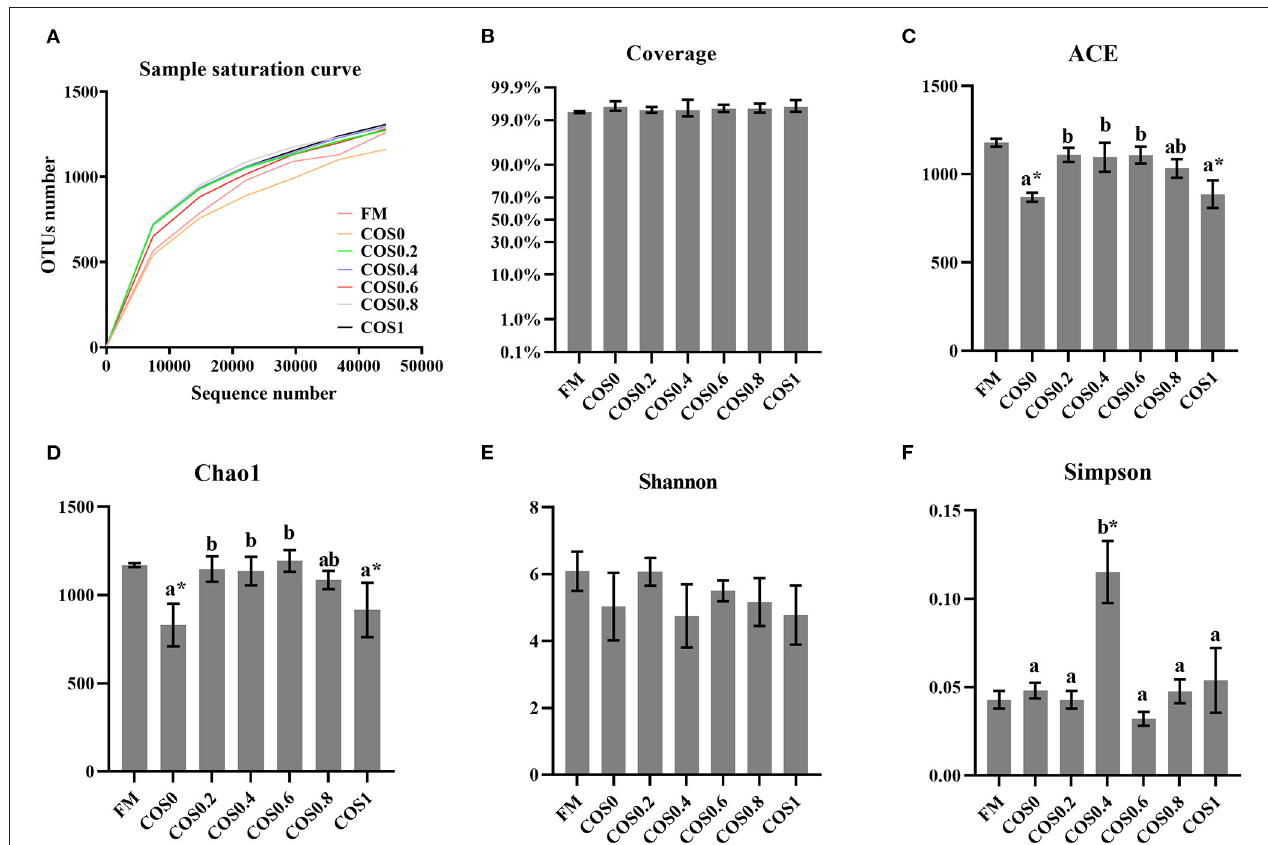
FIGURE 5 | (A) Sample saturation curve analysis of intestinal microbiota in hybrid grouper fed with experimental diets for 8 weeks. (B–F) Alpha diversity indices of intestinal microbiota in hybrid grouper fed with experimental diets for 8 weeks. Values are means ± SEM ( n = 3). Values in the same row with different superscript letters mean significantly different among COS-containing groups ( P < 0.05). The superscript * indicates that this COS-containing group is significantly different from FM group ( P <